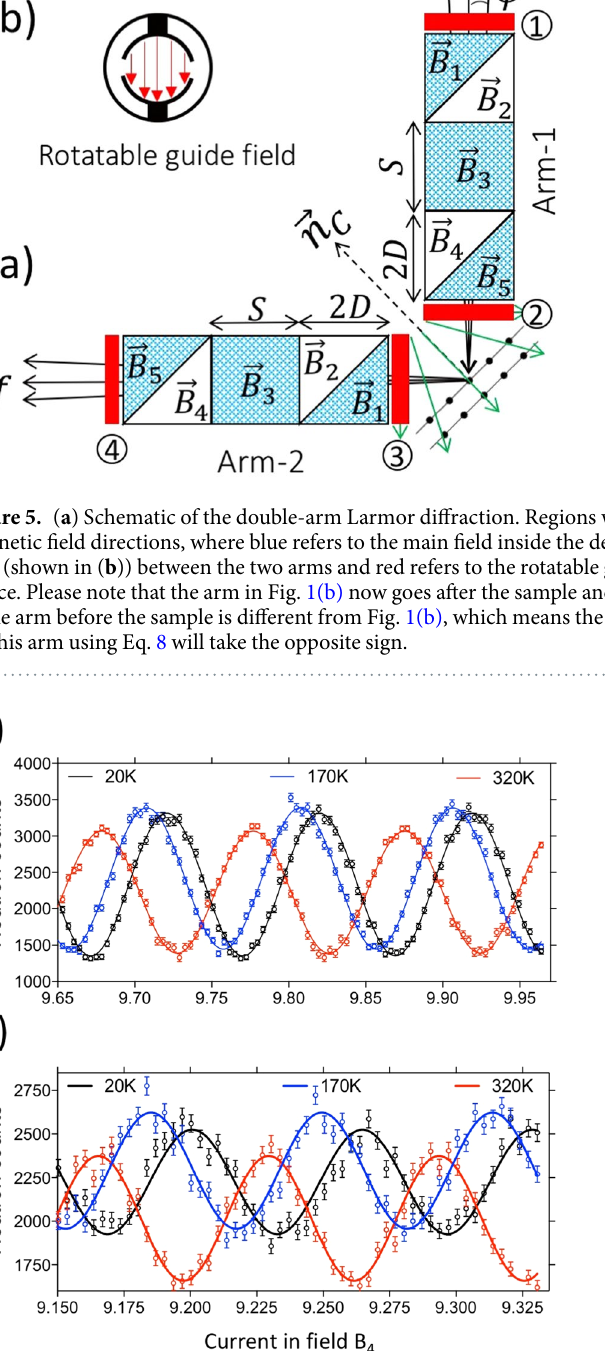
small misorientations of the diffraction planes to first order. This means, unlike the single-arm configuration, the double-arm setup is suitable for crystals with large mosaics.